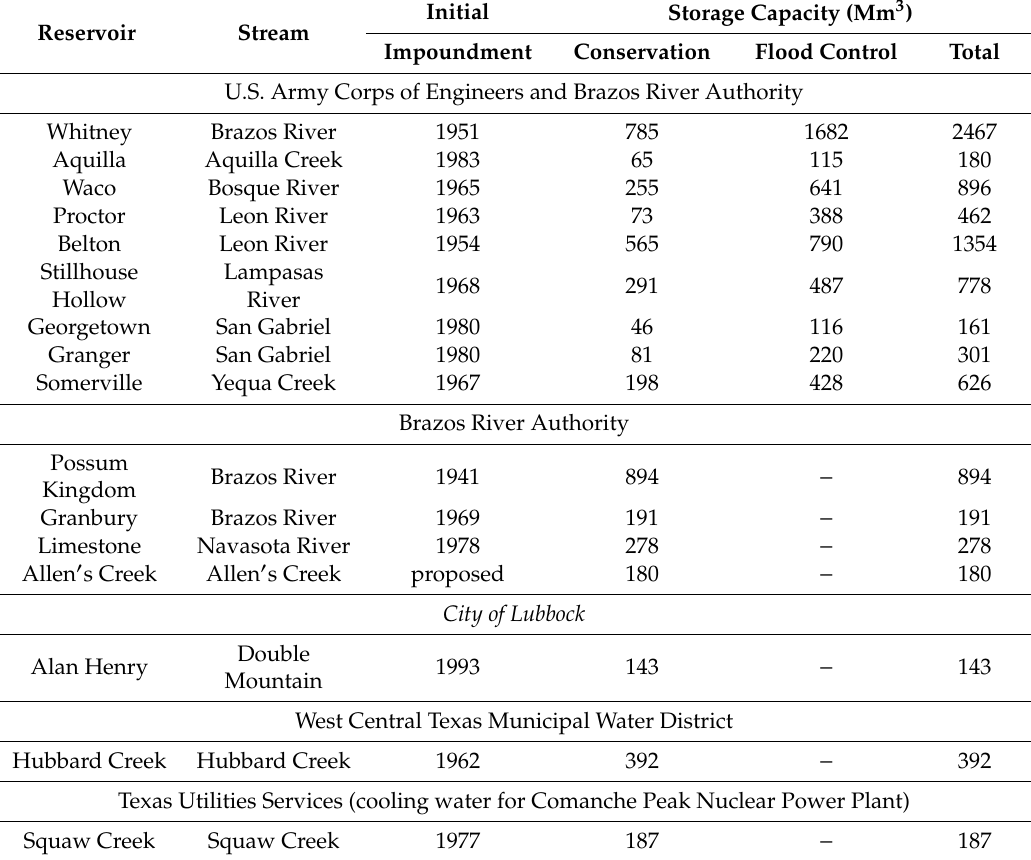
Table 1. Largest reservoirs in the Brazos River